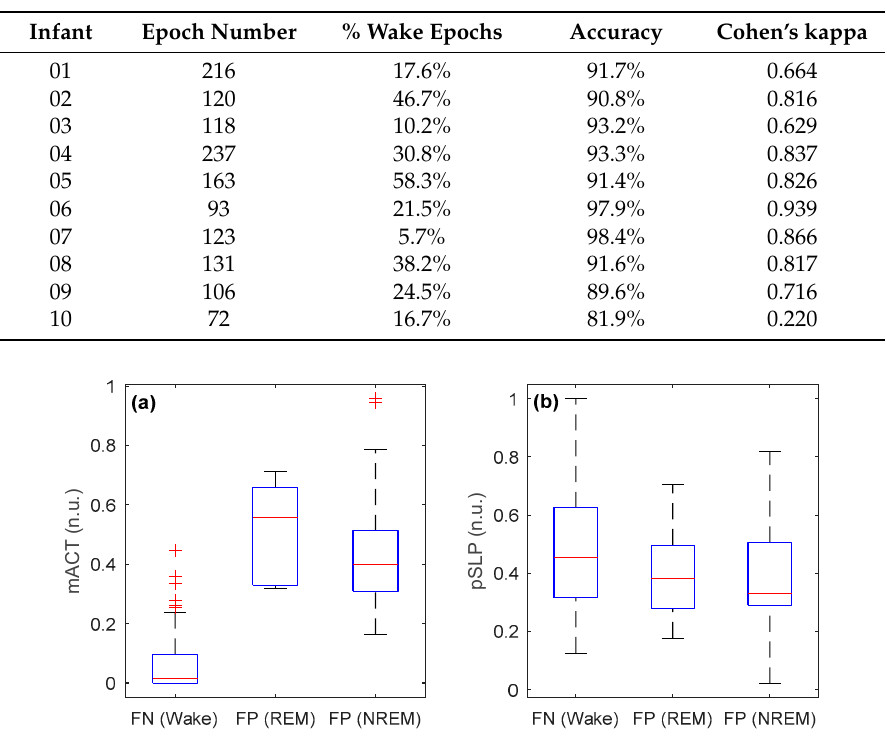
Table 2. Wake and sleep classification results (LOOCV) for each infant.